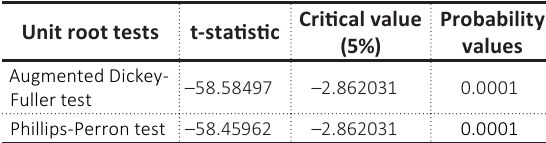
Table 1. Unit root test results